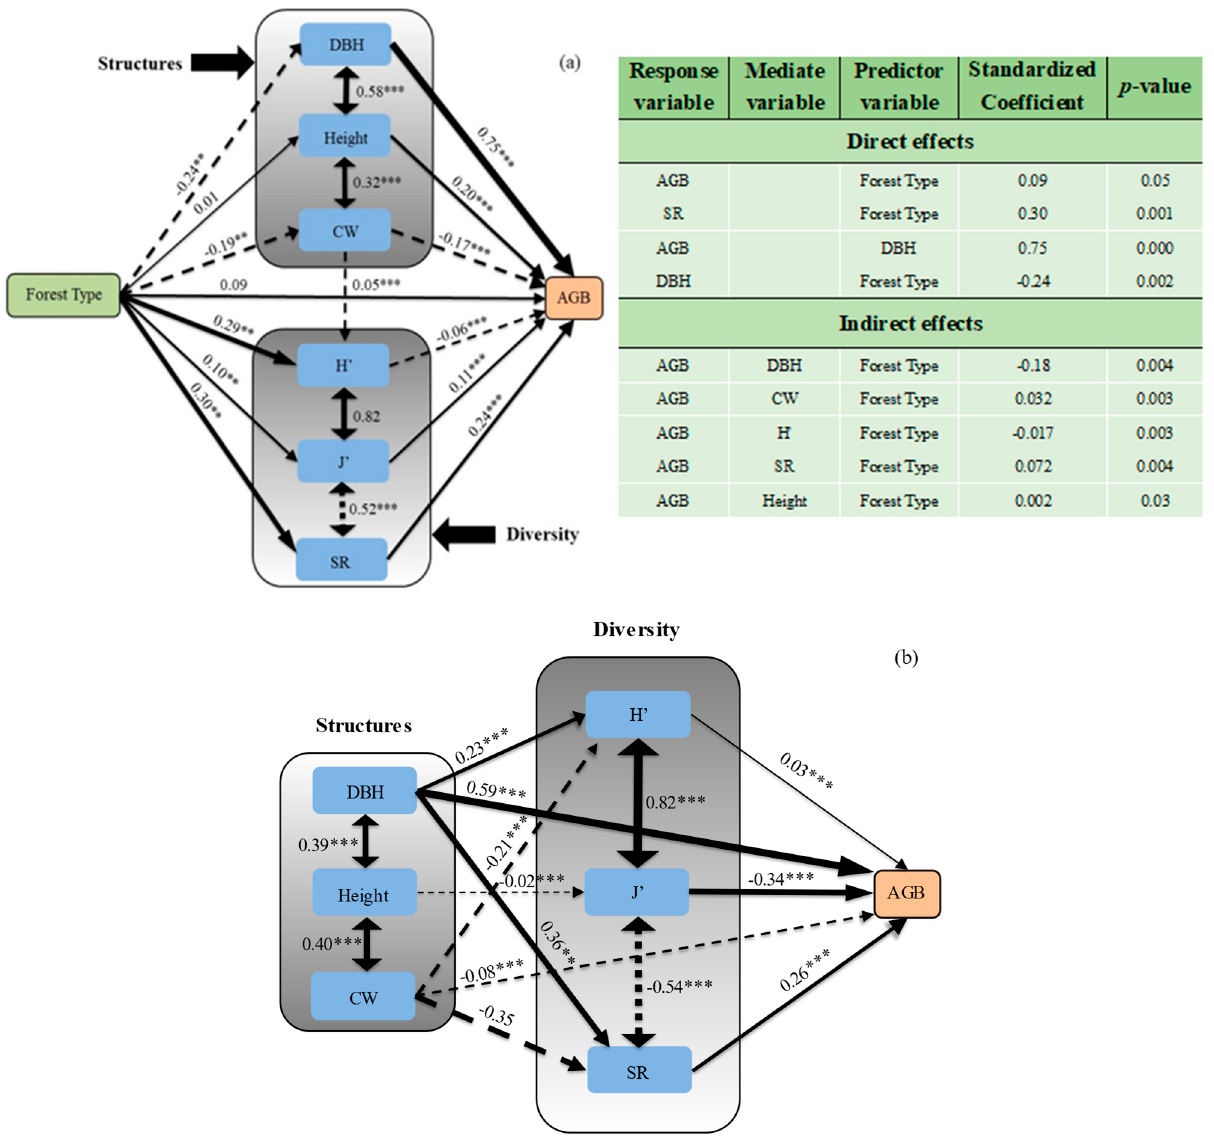
Figure 6. The SEM analysis of the effect of forest type, structures, and diversity on biomass (( a ) represents the overall situation, ( b ) represents the situation of LF). The direct and indirect effects’ standardized coefficient (standard), statistical significance ( p -value) in the table. (** indicated p < 0.01, *** indicated p < 0.001). One-way arrows represent direct causal relationships, the arrows point to the response (result), the starting point is the cause, and the mark on the line is the load; the two variables pointed by the double-headed arrows are correlated (but without a causal equation), labeled as covariance.